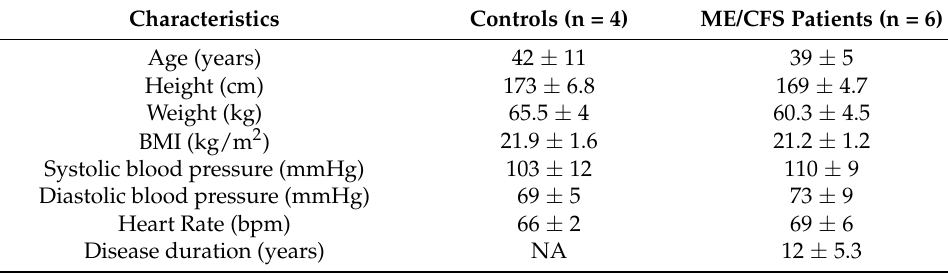
Table 1. Demographic characteristics of the participants. Data are represented as mean ±